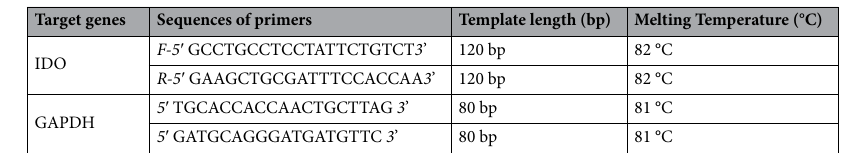
Table 1. Specifications and sequences of IDO and GAPDH specific primers.